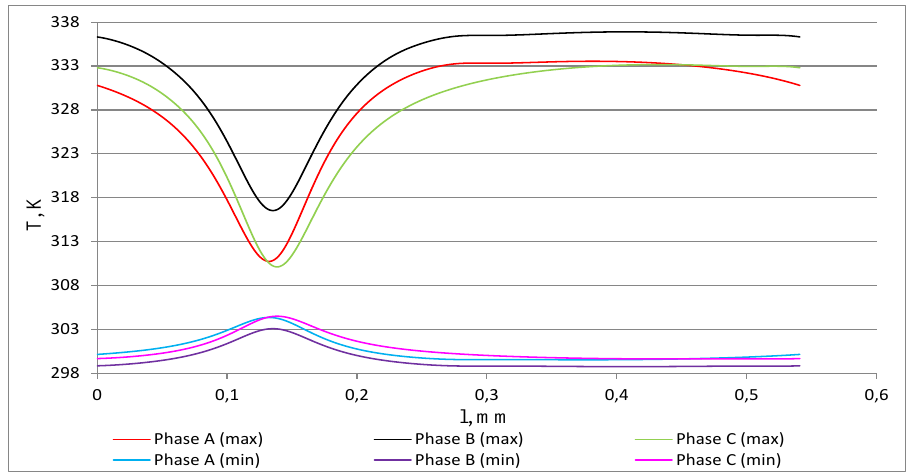
Figure 9. Temperature distribution on the surface of the cable placed in the pipes for the minimum (min) and maximum (max) temperature difference in a flat system.